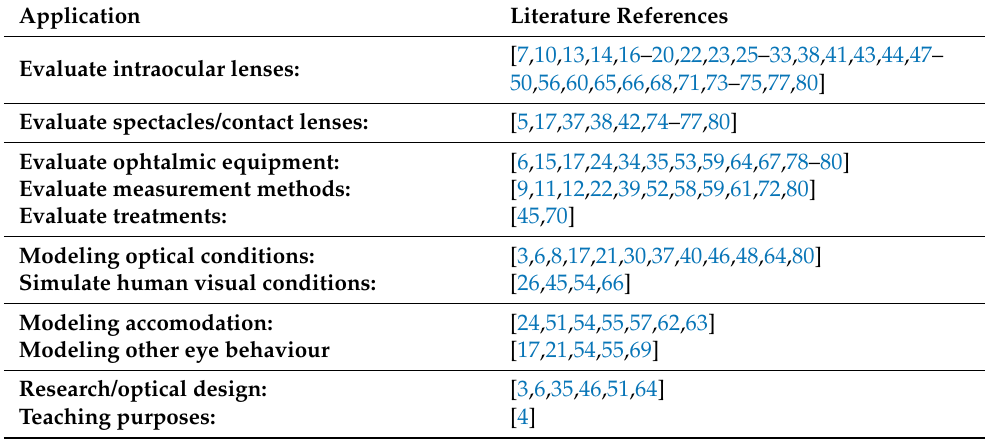
Table 2. Main applications of physical eye models, as reported in the publications reviewed.